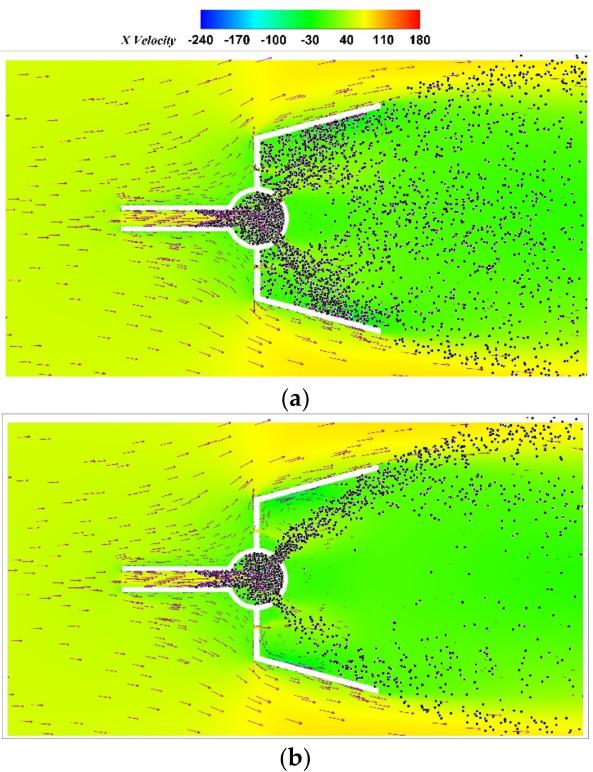
Figure 16. Spray field under different actuation positions with 10 mm actuation length on inner surface: ( a ) P1 position, ( b ) P2 position.